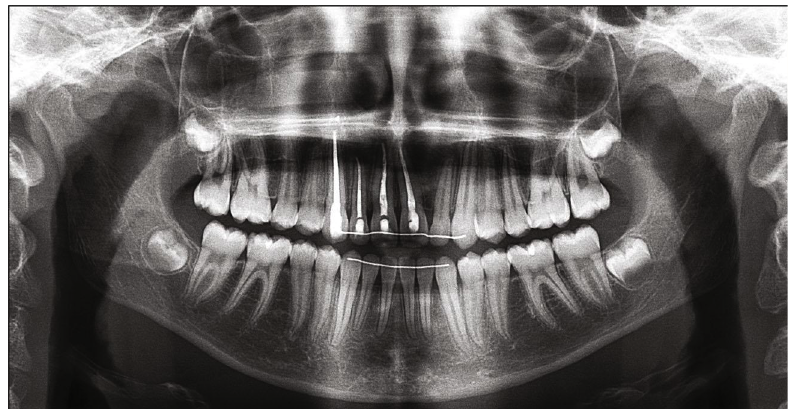
Figure 14: Panoramic radiograph after treatment.